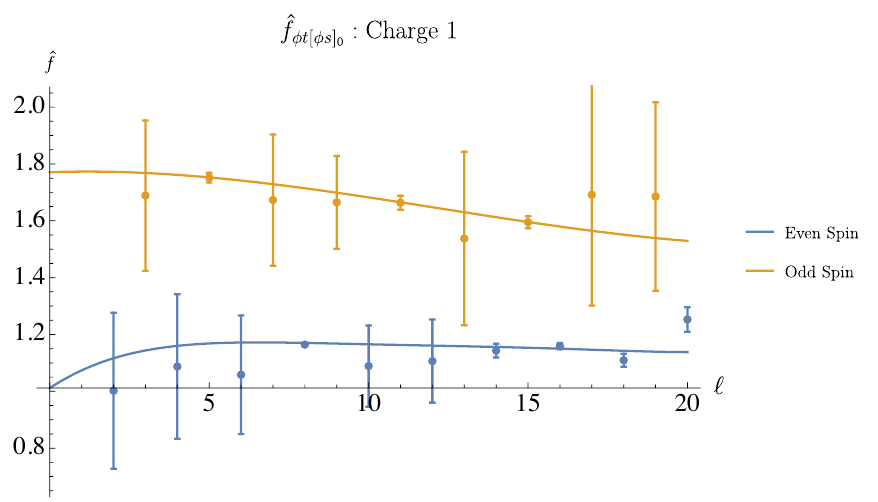
Figure 12 . Analytic and numerical predictions for \o(cid:11)-diagonal" three-point coe(cid:14)cients between external operators (cid:30) , t and operators on the double-twist trajectories [ (cid:30)s ] 1 both even and odd spin. The blue curve represents the even-spin trajectory while the orange curve represents the odd-spin trajectory. We normalize the OPEs such that the asymptotic values are one.